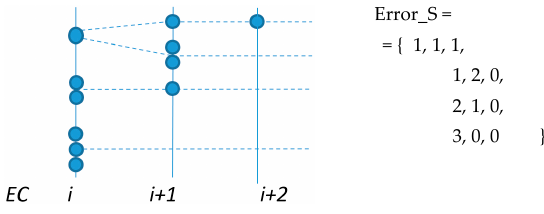
Figure 7. Possible error sequences in consecutive cycles.